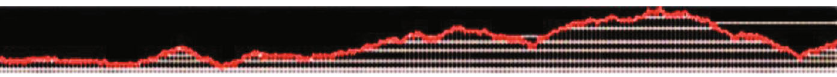
Figure 3: Adapted run ’ s step height (2000 steps, 25 meters